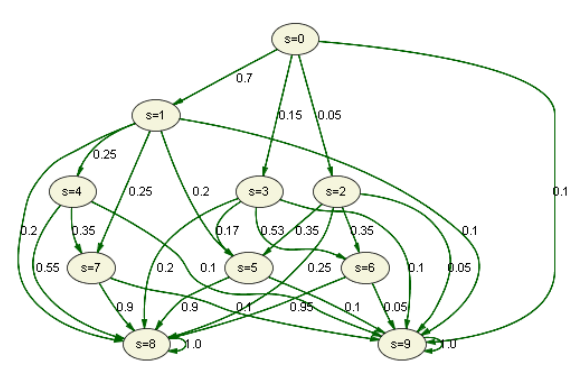
Fig. 6. Markov chain usage